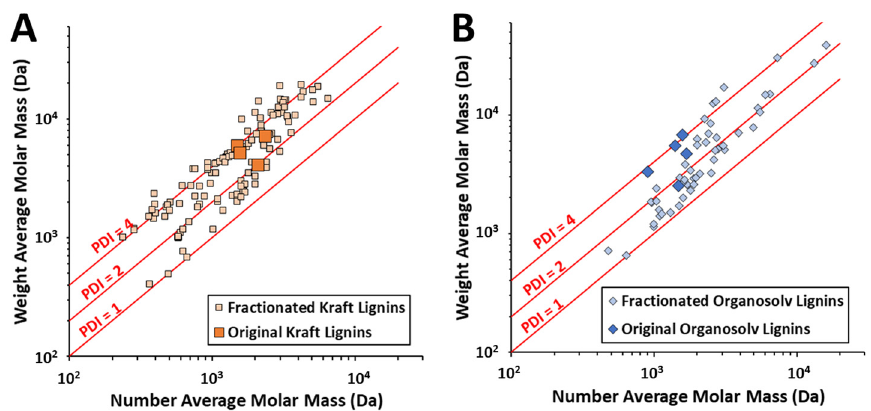
Figure 3. Demonstration of lignin fractionation to yield diverse molar masses from ( A ) Kraft lignins from [39–45] and ( B ) organosolv lignins from [46–50]. Contours for polydispersity index (PDI) are presented for reference.